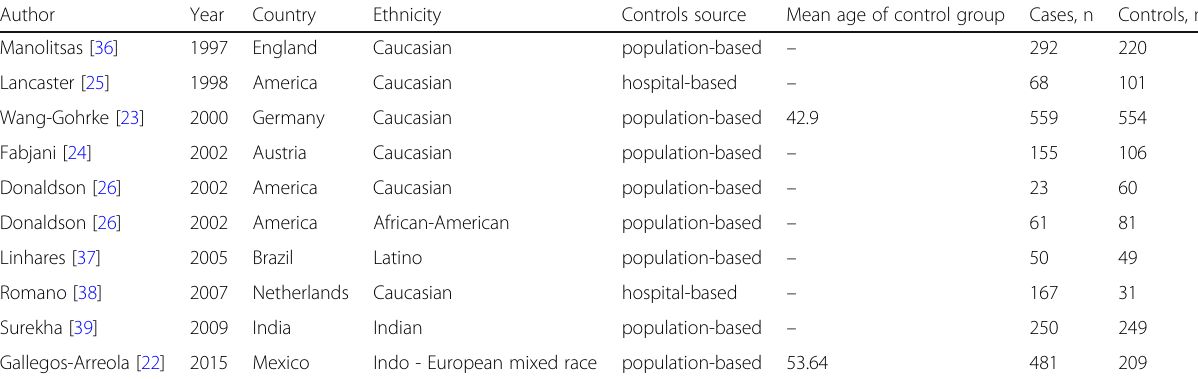
Table 1 Baseline characteristics of qualified studies in this meta-analysis